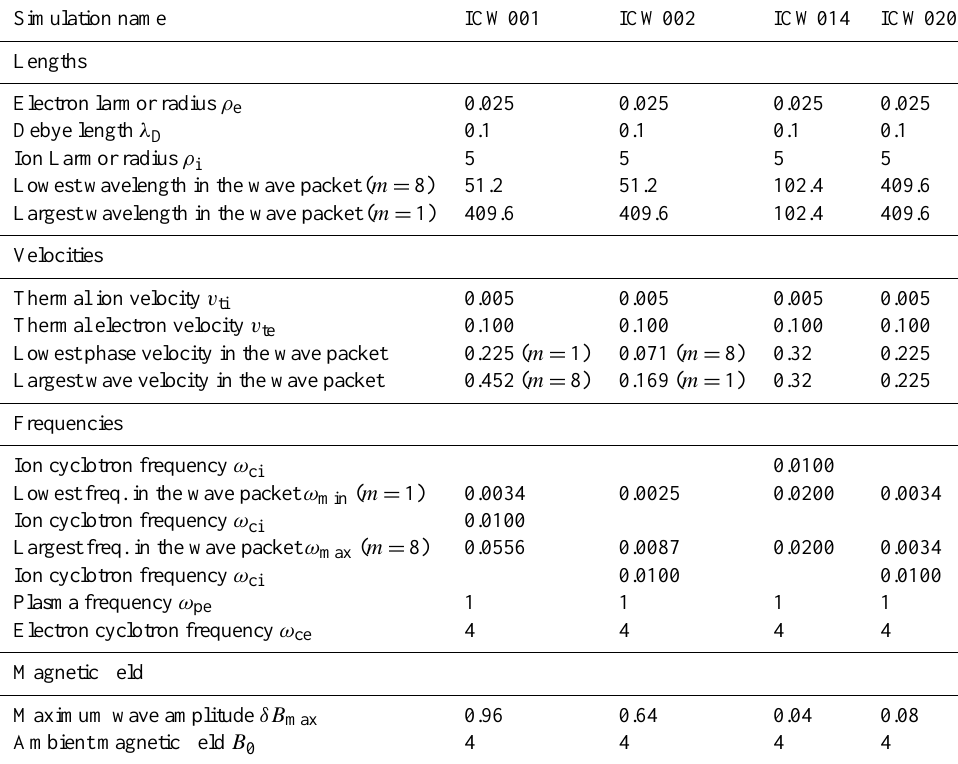
Table 2. Plasma characteristic values in the initial conditions of simulations ICW001, ICW002, ICW014, ICW20. For each categories (lengths, velocities, frequencies, magnetic field), the data is ordered from the smaller to the largest values. The parameters that are varied from one simulation to another are boldfaced. One can notice that the value of the ion cyclotron frequency is plotted in two lines because of different orderings in IWC001, IWC002, ICW014 and ICW020. The data about the wave is given for a single wave packet; the characteristics of the second wave packet are the same, apart from their opposite directions of